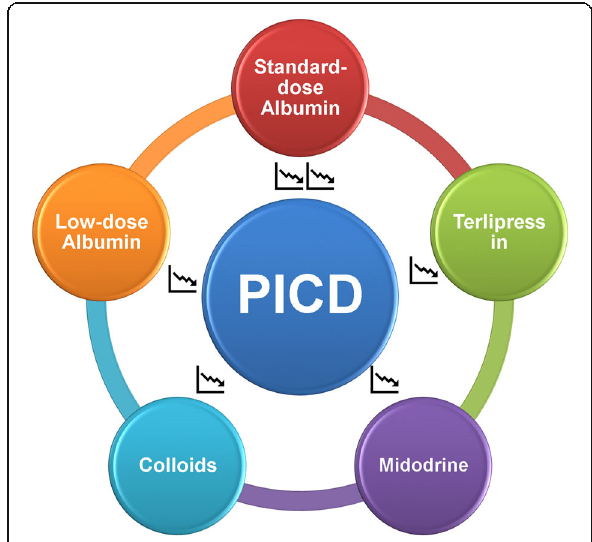
Fig. 1 Drugs used for the prevention of the paracentesis-induced circulatory